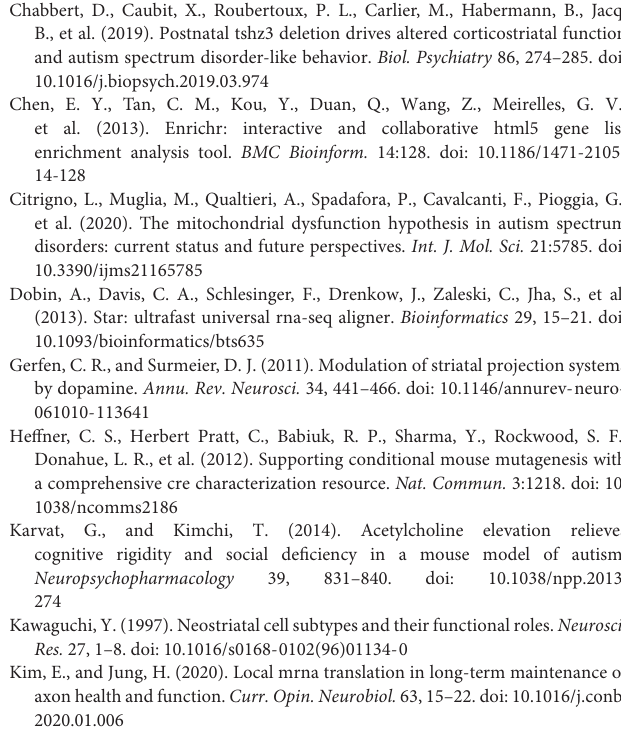
Supplementary Figure 1 | Interactome view of 36 mitochondrial processes within the DEGs. Striatal DEGs are distributed in 31 mitochondrial processes, especially within oxidative phosphorylation, translation as well as replication and transcription. Individual bubbles represent genes of a process; blue and red, indicate up- or down-regulated genes within a process, respectively. Bubble size indicates log2 fold change values. This scheme was built using the “Interactome View” tool available on mitoXplorer web-plateform